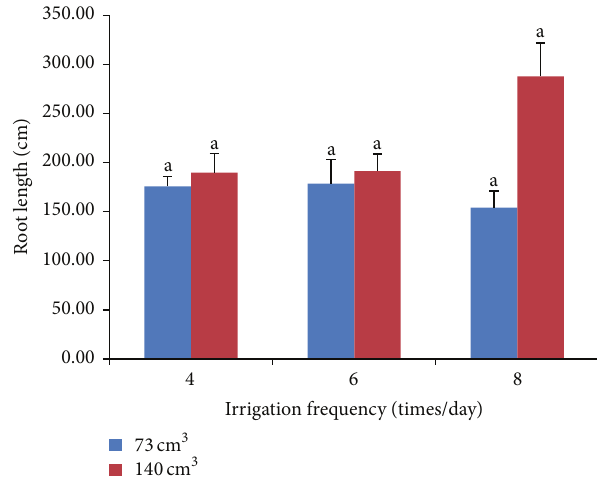
Figure 3: Interaction effects of substrate volumes and irrigation frequencies on root length of chrysanthemum.